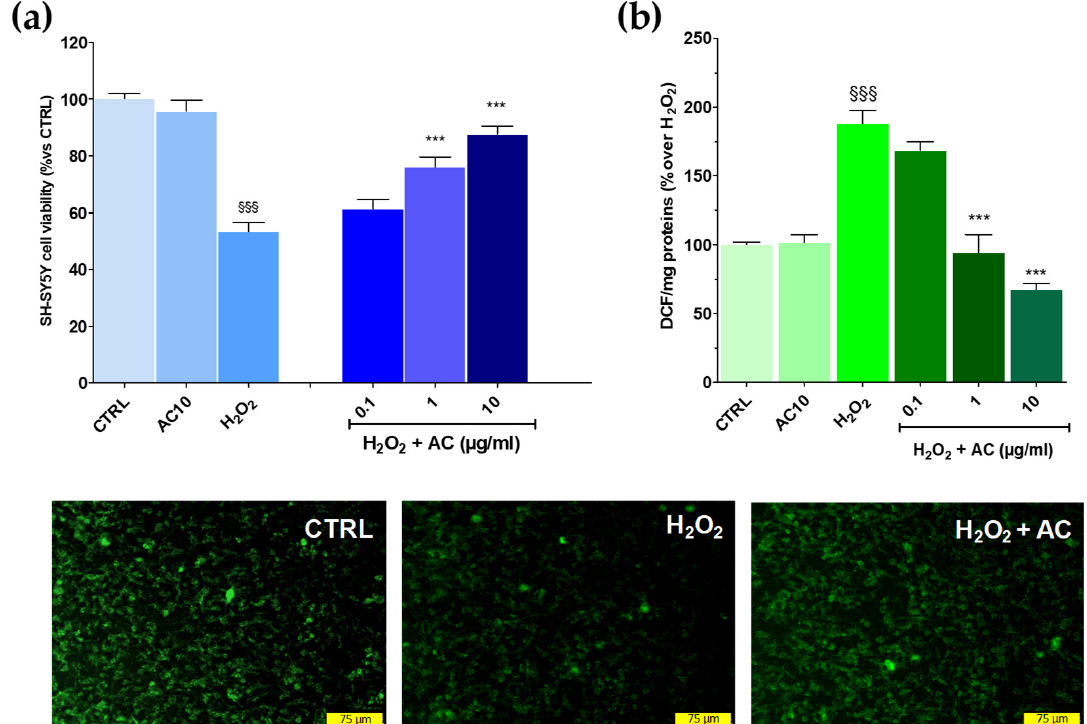
Figure 3. Effects of AC on oxidative stress (OS)-induced cytotoxicity, formation of ROS, and mitochondria membrane potential loss in SH-SY5Y cells. ( a ): Cell viability: cells were treated with AC (0.1–10 µg/mL) according to the pre- and post-treatment protocol described in Materials and Methods. OS was reproduced by using H 2 O 2 (25 µM for 1 h + 24 h with medium). The effects of AC per se were tested at 10 µg/mL (AC10). ( b ): ROS formation as evaluated by the oxidation of DCF-DA to DCF on cells subjected to the AC pre- and post-treatment protocol and OS. Data are reported as means ± SEMs. §§§ p < 0.001, vs. untreated cells (CTRL); *** p < 0.001, vs. H 2 O 2 (ANOVA and Bonferroni post-hoc test). (Lower panels): Representative fluorescence images of changes in the mitochondrial membrane potential, as assessed by Rhodamine 123 staining in cells subjected to the AC 10 µg/mL pre- and post-treatment protocol and OS. Each photograph was representative of at least three independent observations (scale bar 75 µm).